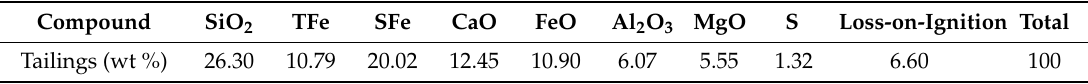
Figure 1. The cemented tailings backfill system in the Daye Iron Mine: ( a ) cemented tailings backfill plant; ( b ) cement tailings slurry; ( c ) transportation pipe for backfill slurry; ( d ) backfill in field stope. Table 1. Main chemical composition of the tailings used.